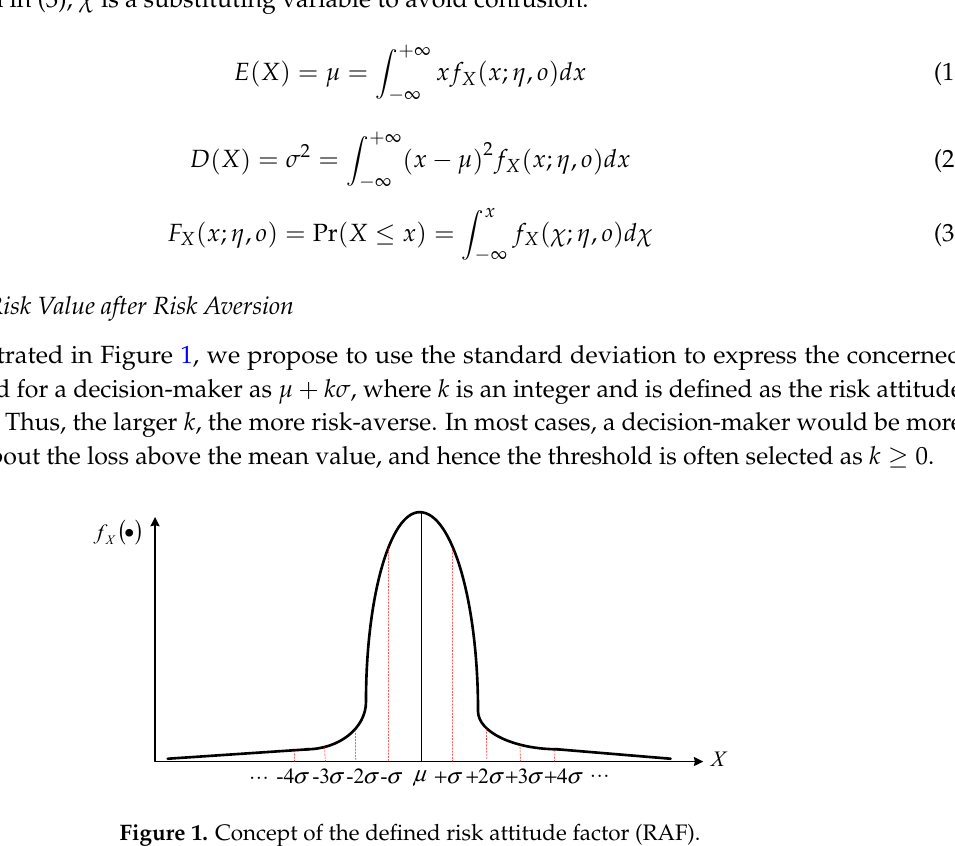
Figure 1. Concept of the defined risk attitude factor (RAF).